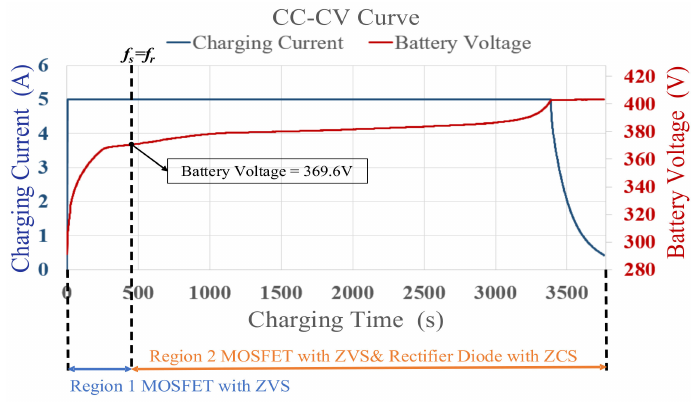
Figure 8. CC–CV curve when N = 1.08.